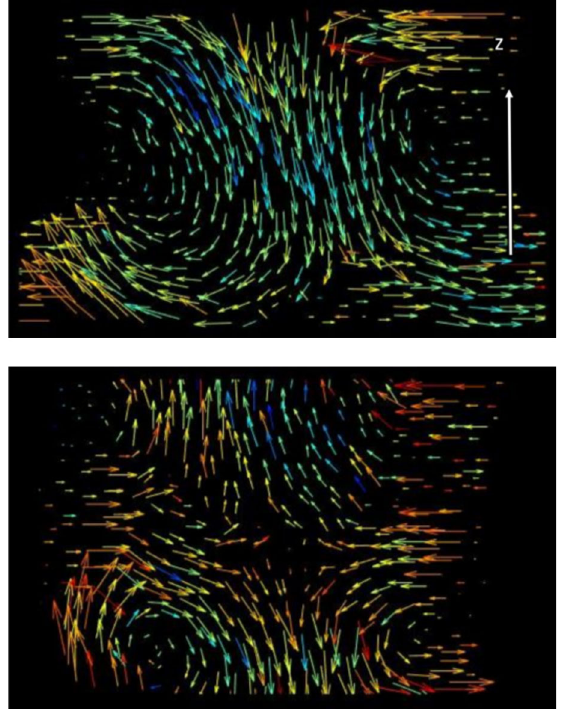
FIG. 9. Mechanical shear modes. Displacement and strain fields for the tilted solution T for two low eigenvalues. The vectors show the direction of the displacement and the color code denotes the strain (i.e., the local change in the vector field as a function of position; maximal stress is